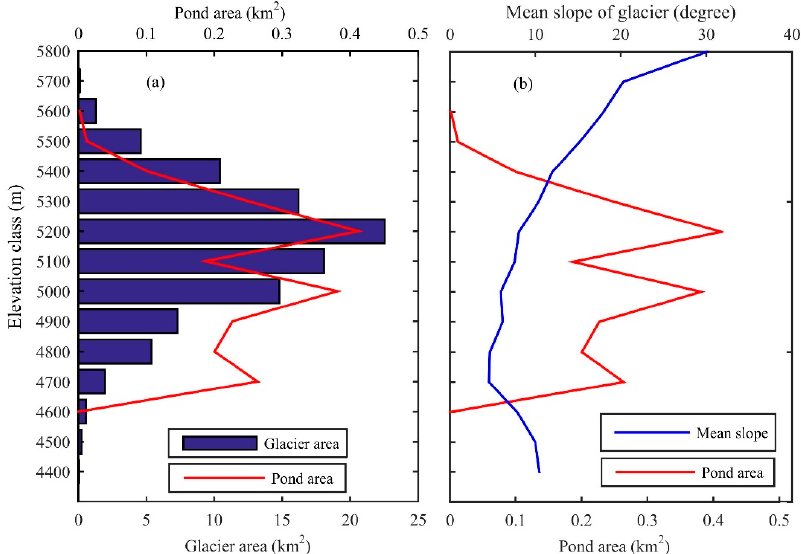
Figure 4. The relationship between ponded area and glacier characteristics with ( a ) elevation and ( b ) slope. The altitudinal area distribution of the debris portion of the glacier and area of all supraglacial ponds were mapped using 2-m resolution imagery in the Everest region. The elevation class value on the y -axis indicates the uppermost value.